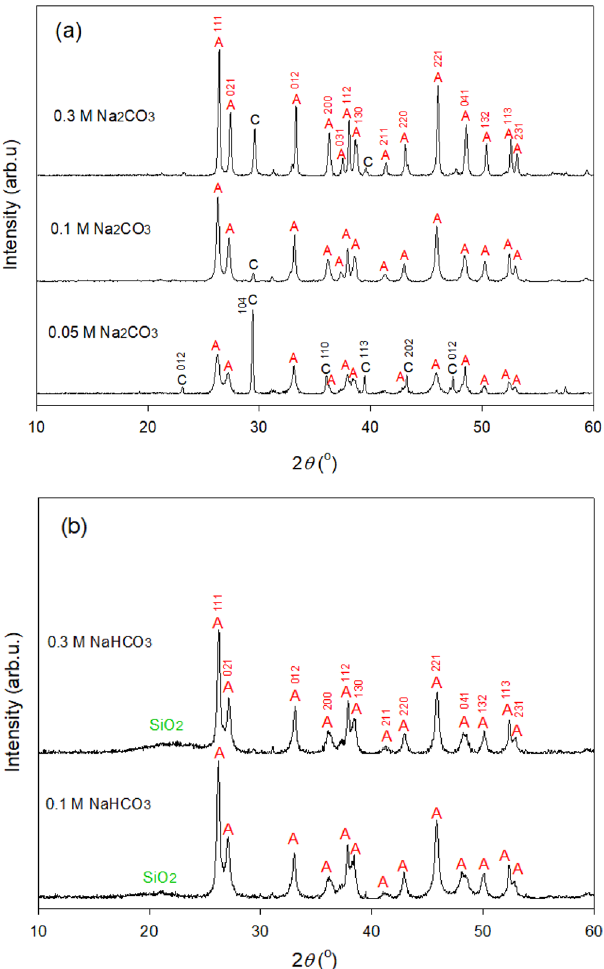
Figure 6. XRD patterns of CaCO 3 precipitated during carbonation with ( a ) 0.05–0.3 M Na 2 CO 3 and ( b ) 0.1–0.3 M NaHCO 3 in 0.03 M GLDA at 80